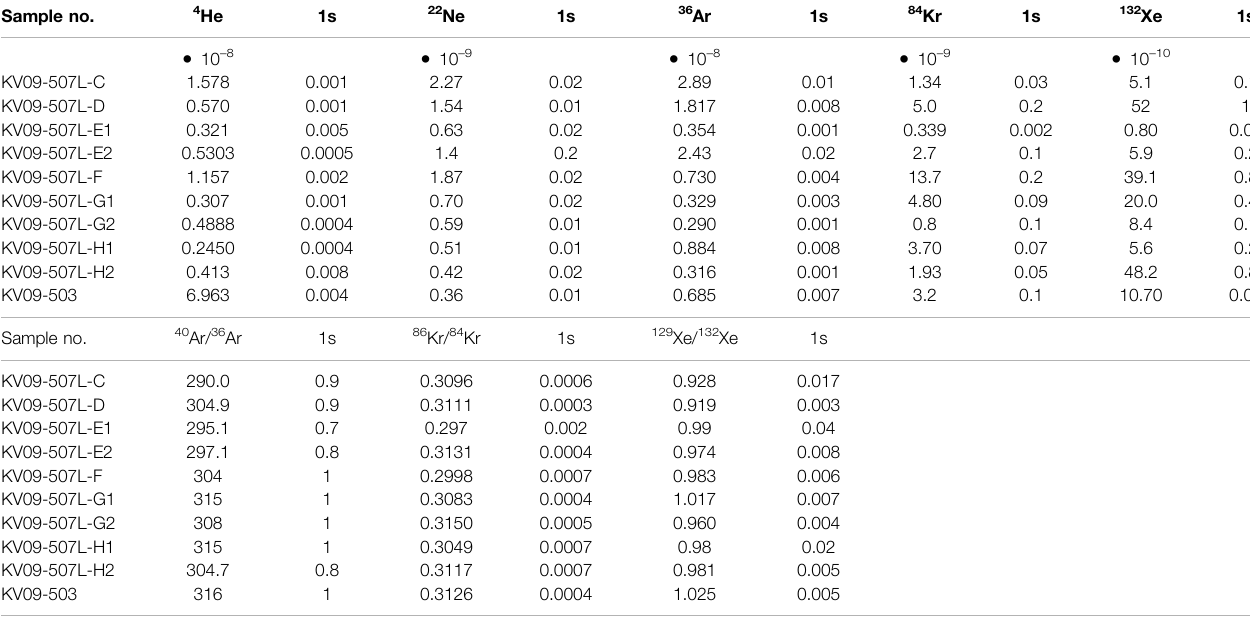
TABLE 2 | Noble gas data for growth horizons in the gypsum section (KV09-507) and the 1-year gypsum growth (KV09-503). Sample no.